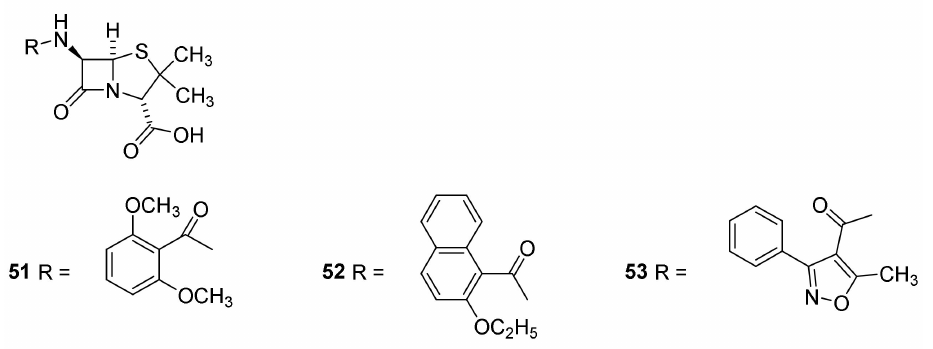
Figure 11. Examples of β -lactamase resistant penicillins, methicillin ( 51 ), nafcillin ( 52 ) and oxacillin ( 53